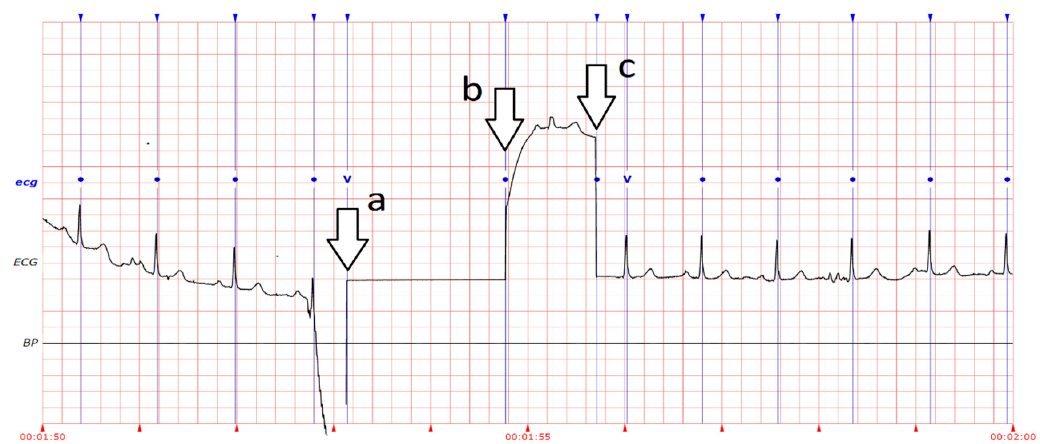
Figure 7. (a, b, and c) Typical waveforms, which sometimes occurred and were annotated as beats in the Fantasia database, but cannot be recognized by the automata as heartbeats [12 – 15].